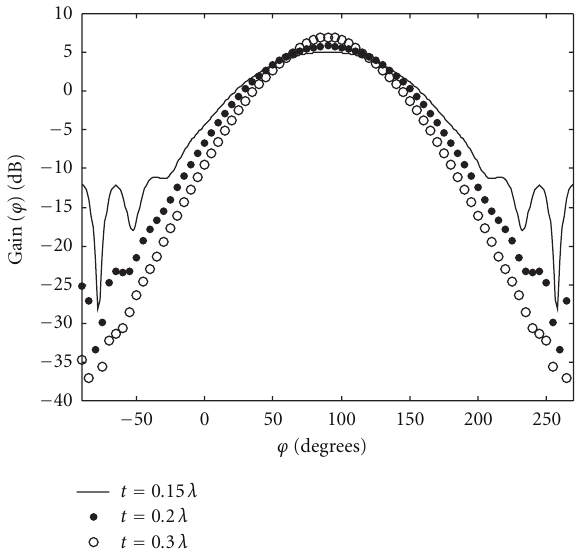
Figure 3: Radiation pattern of an axially slotted elliptic cylinder coated with magnetic metamaterials. a c = λ , b c = λ /2, b = b c + t , ν = 90 ◦ , α = 2 . 8657 ◦ , ε r = − 4 . 0, and μ r = − 1 . 5. 0